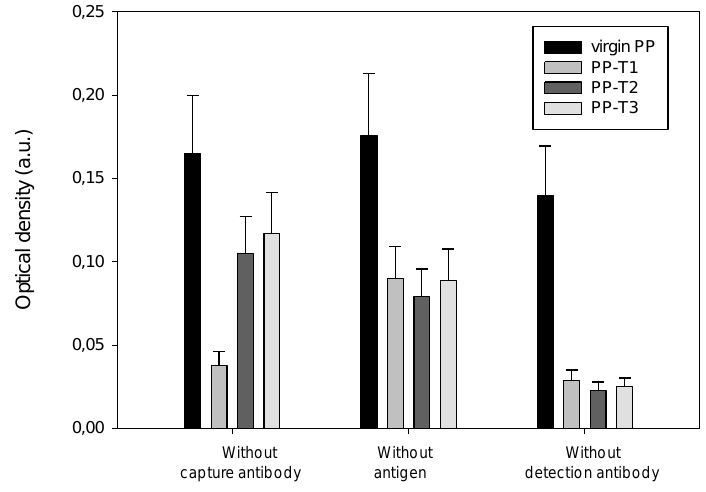
Figure 6. Evaluation of non-specific associations for each surface treatment during PrPrechum ELISA